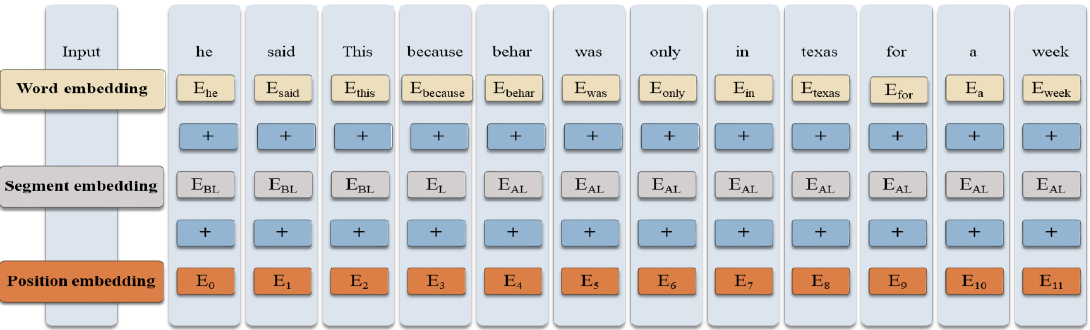
Figure 2. Input representation for MCKN. The word, segment, and position embedding are added to create the input embedding.